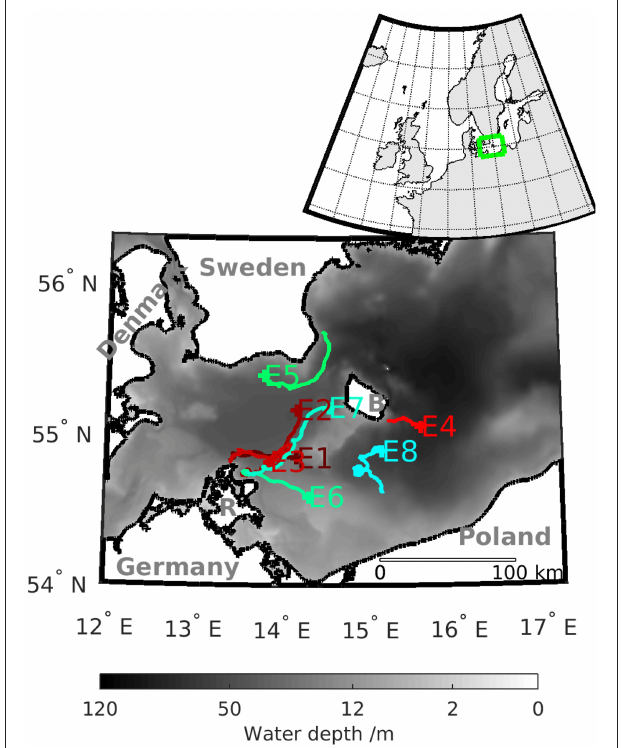
FIGURE 1 | Bathymetry of the Western Baltic Sea and the numbered tracks of the selected eddies detected with M V . The label of the tracks indicates the position where the eddy decays. The island of Rügen is marked with R and the island of Bornholm with B. The insert in the upper right corner shows the position of the Western Baltic Sea on the European